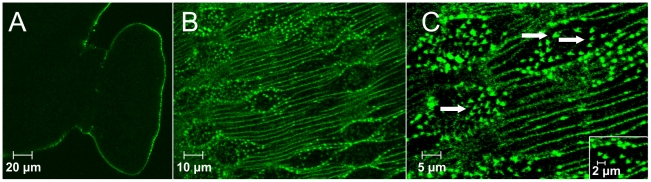
Immunocytochemistry of host CD44 on the S. mansoni tegument surface.(A) OTC-embedded parasite sections and (B/C) freshly perfused live parasites were labelled with rat anti-mouse CD44. In worm sections, CD44 staining was confined exclusively to the parasite surface. Figure (A) represents the CD44 staining of the tegument in the ventral sucker region. (B) Slice from a Z-stack of the male tegument after CD44 staining of live worms. (C) Higher magnification of (B) showing a striking inverted V pattern for CD44 staining being mostly concentrated at the tip of the spines (arrowed).